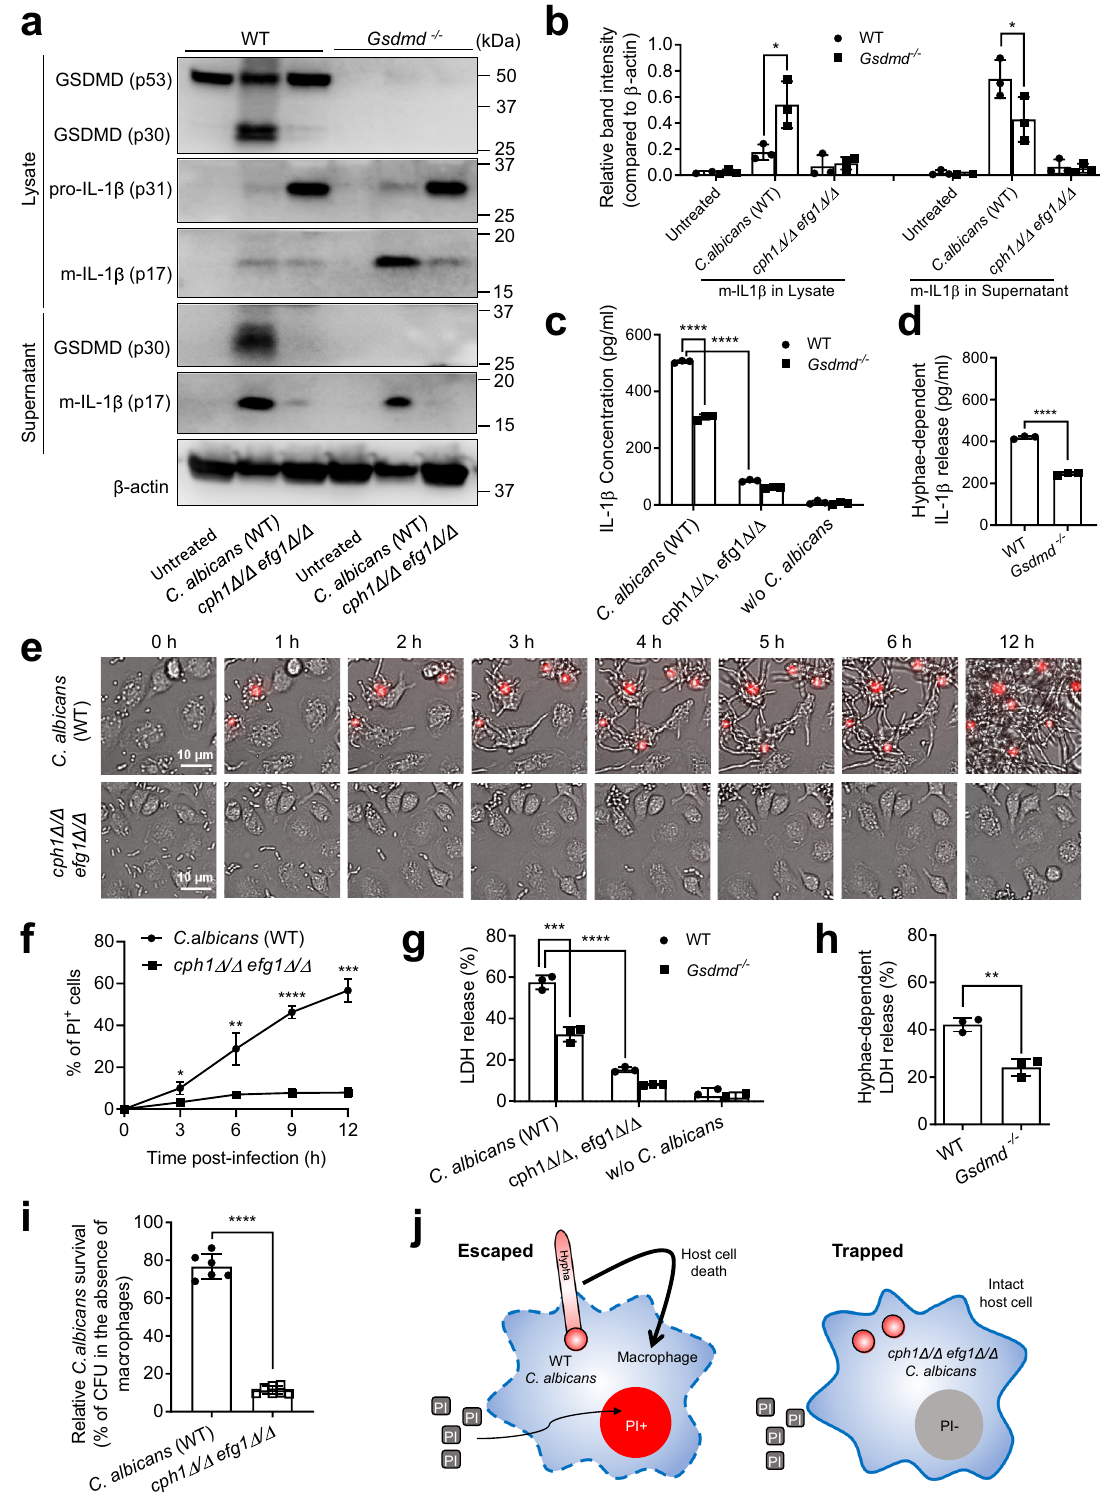
caspase-1-mediated canonical in fl ammasomes and caspase-11- mediated non-canonical in fl ammasomes. GSDMD cleavage was ef fi ciently blocked by VX-765, a speci fi c caspase-1/caspase-4 inhibitor (Fig. S6a), suggesting that C. albicans -induced GSDMD cleavage and activation were mainly mediated by canonical in fl ammasomes and caspase-1 (Fig. S6b). The serine protease inhibitor diisopropyl fl uorophosphate (DFP) failed to inhibit